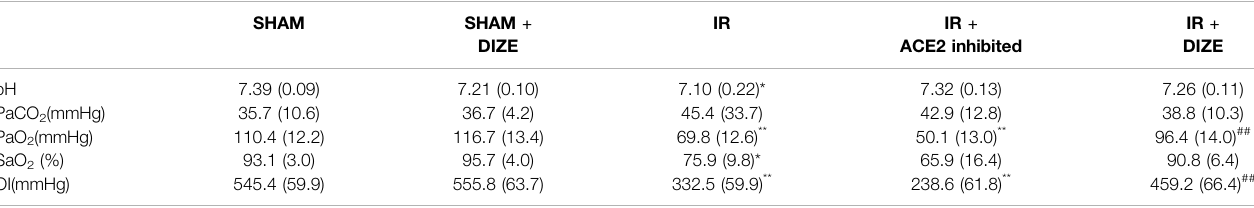
TABLE 2 | Parameters of arterial blood gas in different groups.